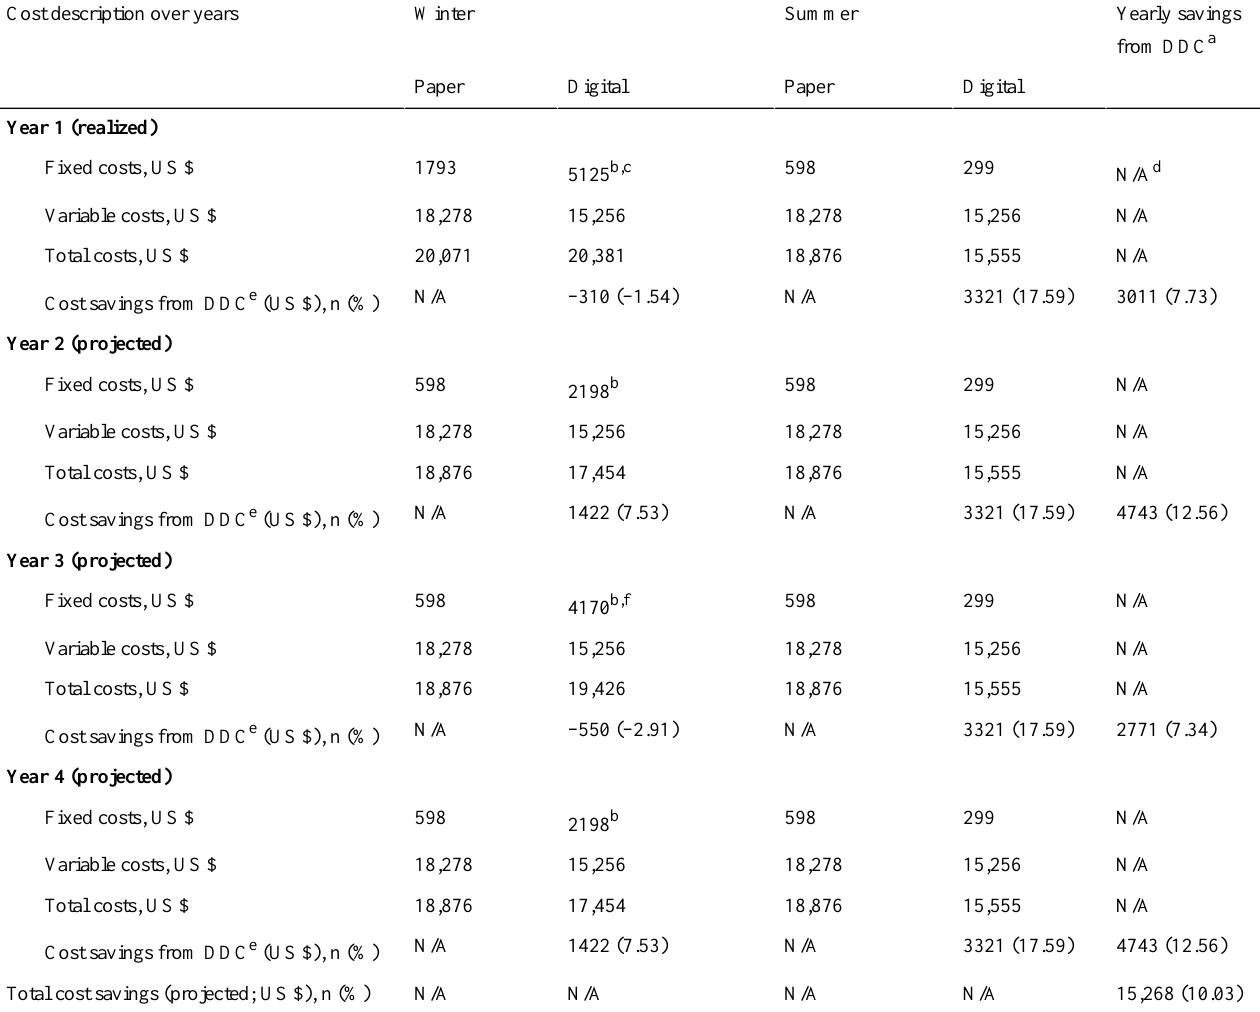
Table 5. Realized and projected cost savings by switching to digital data collection in US